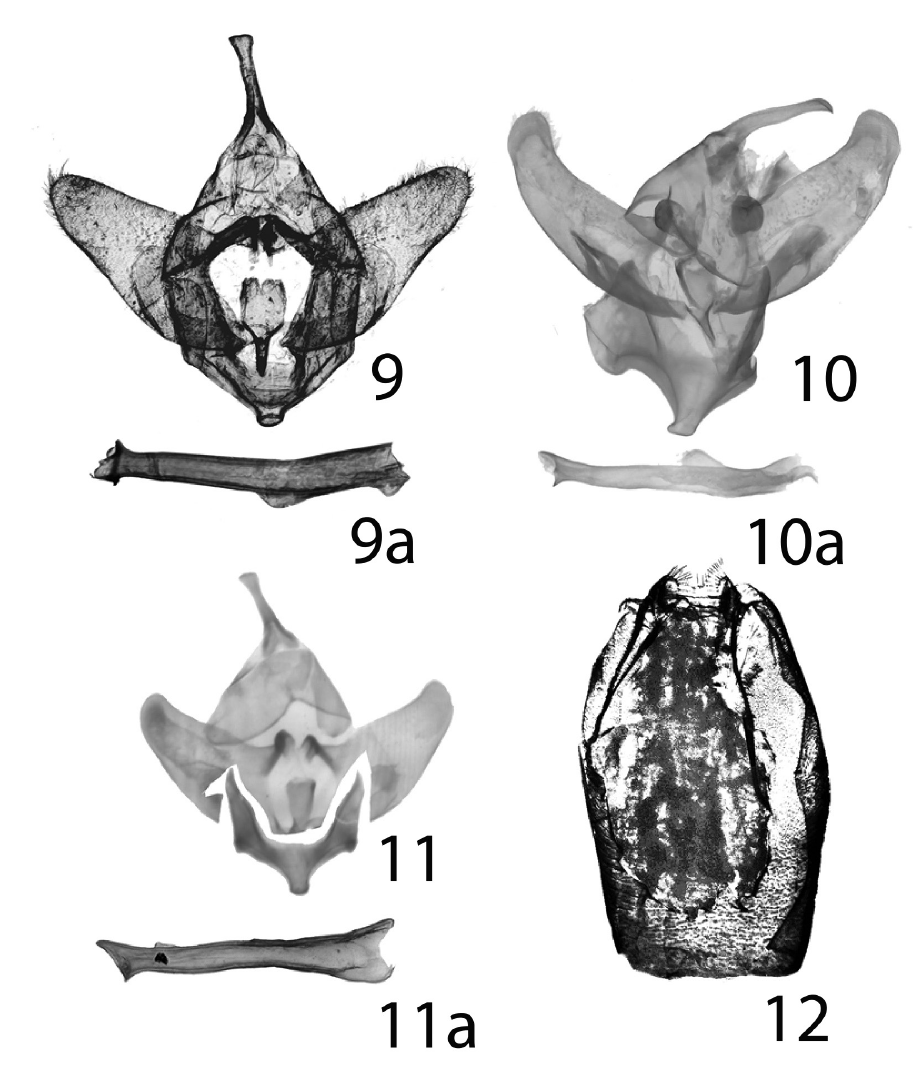
dorsal surface white scales, ventral surface naked, densely setose. Thorax. Thoracic scales hair-like, erect, fuzzy in appearance, white, tegulae similar; underside, scales hair-like, erect, fuzzy in appearance, concolorous. Fore legs denwsely scaled, white, lateral surfaces with long shaggy scales, scattered dark-gray scales, hair-like, erect, fuzzy appearance, hind leg femur one terminal pair of spurs. Forewing: length